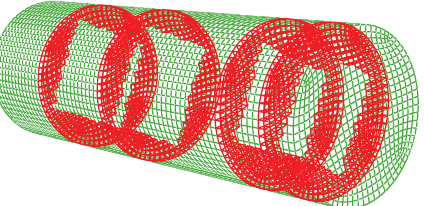
Figure 11: Preexisting structural cracks in the analyzed specimen. The finite element mesh is also shown.